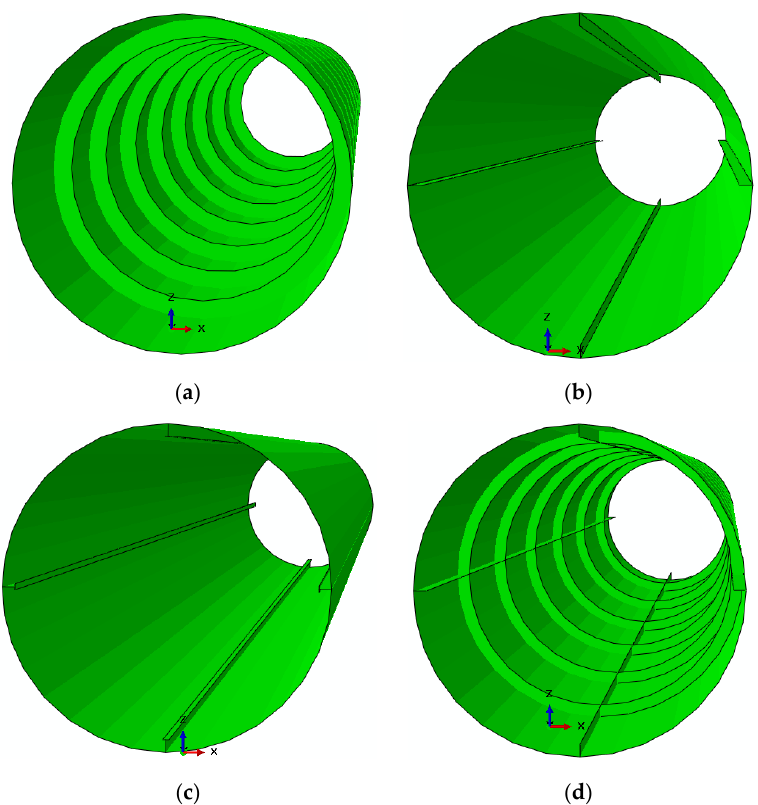
Figure 11. Geometric data of the stiffeners in the cross-section view of the tower (in mm).